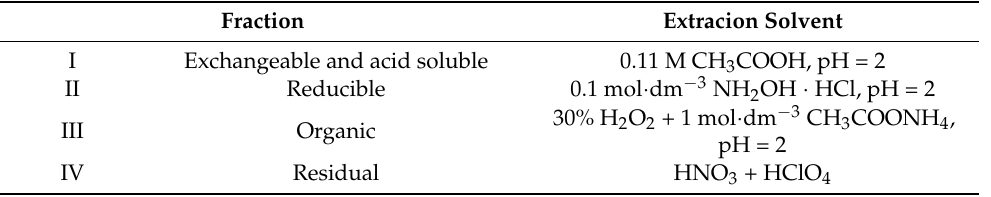
Table 1. Scheme of the sequential analysis of metals according to BCR. Fraction Extracion